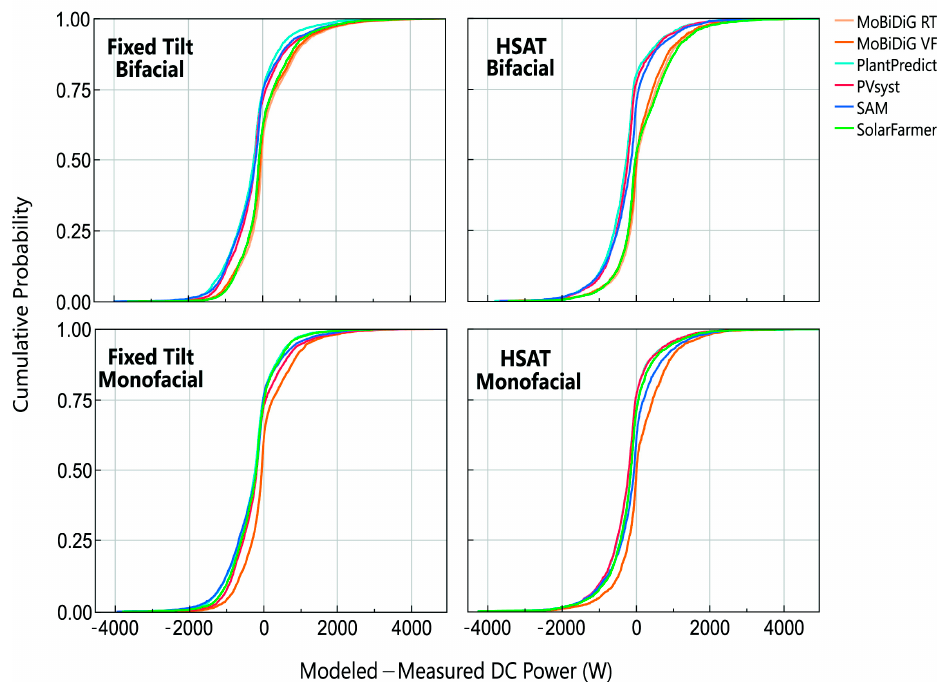
Figure 9. Cumulative distribution functions of the modeling error observed in DC power. Results from four system types and six software are shown. These plots are generated using the residuals from Figure